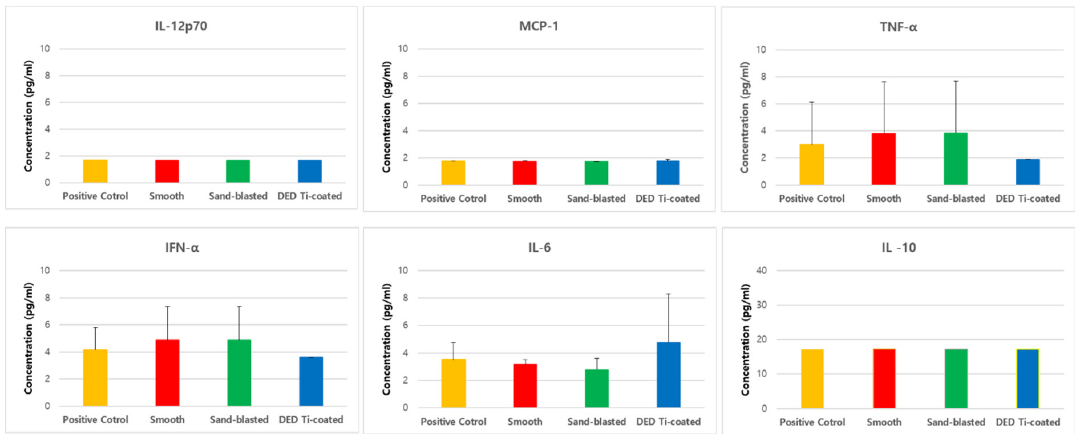
Figure 8. Results of the inflammatory cytokine multiplex assay showing that there were no significant differences among the four experimental groups with respect to cytokine production (all p > 0.05). (IL: interleukin, MCP: monocyte chemoattractant protein, TNF: tumor necrosis factor, IFN: interferon).